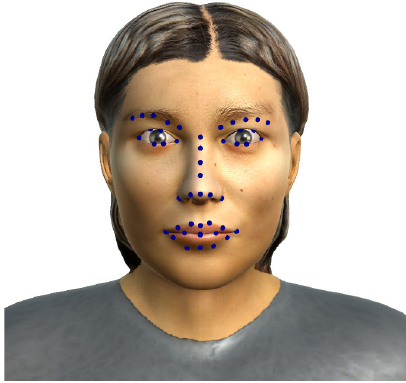
Figure 2. Landmarks in